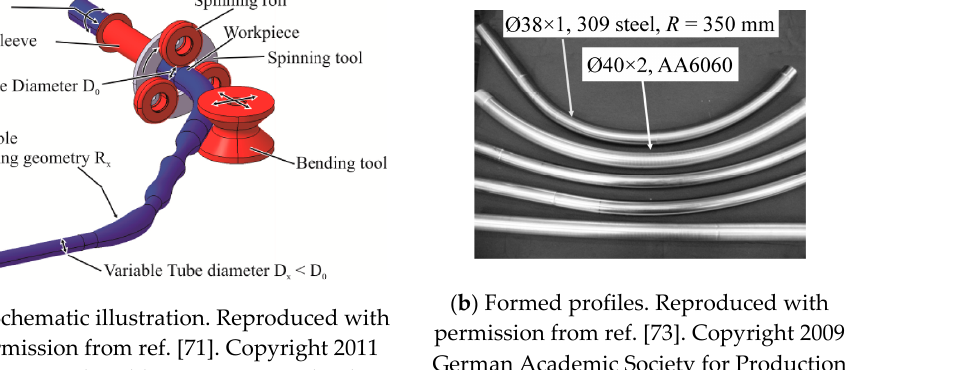
Figure 18. Process of incremental tube forming (ITF) [71,73].